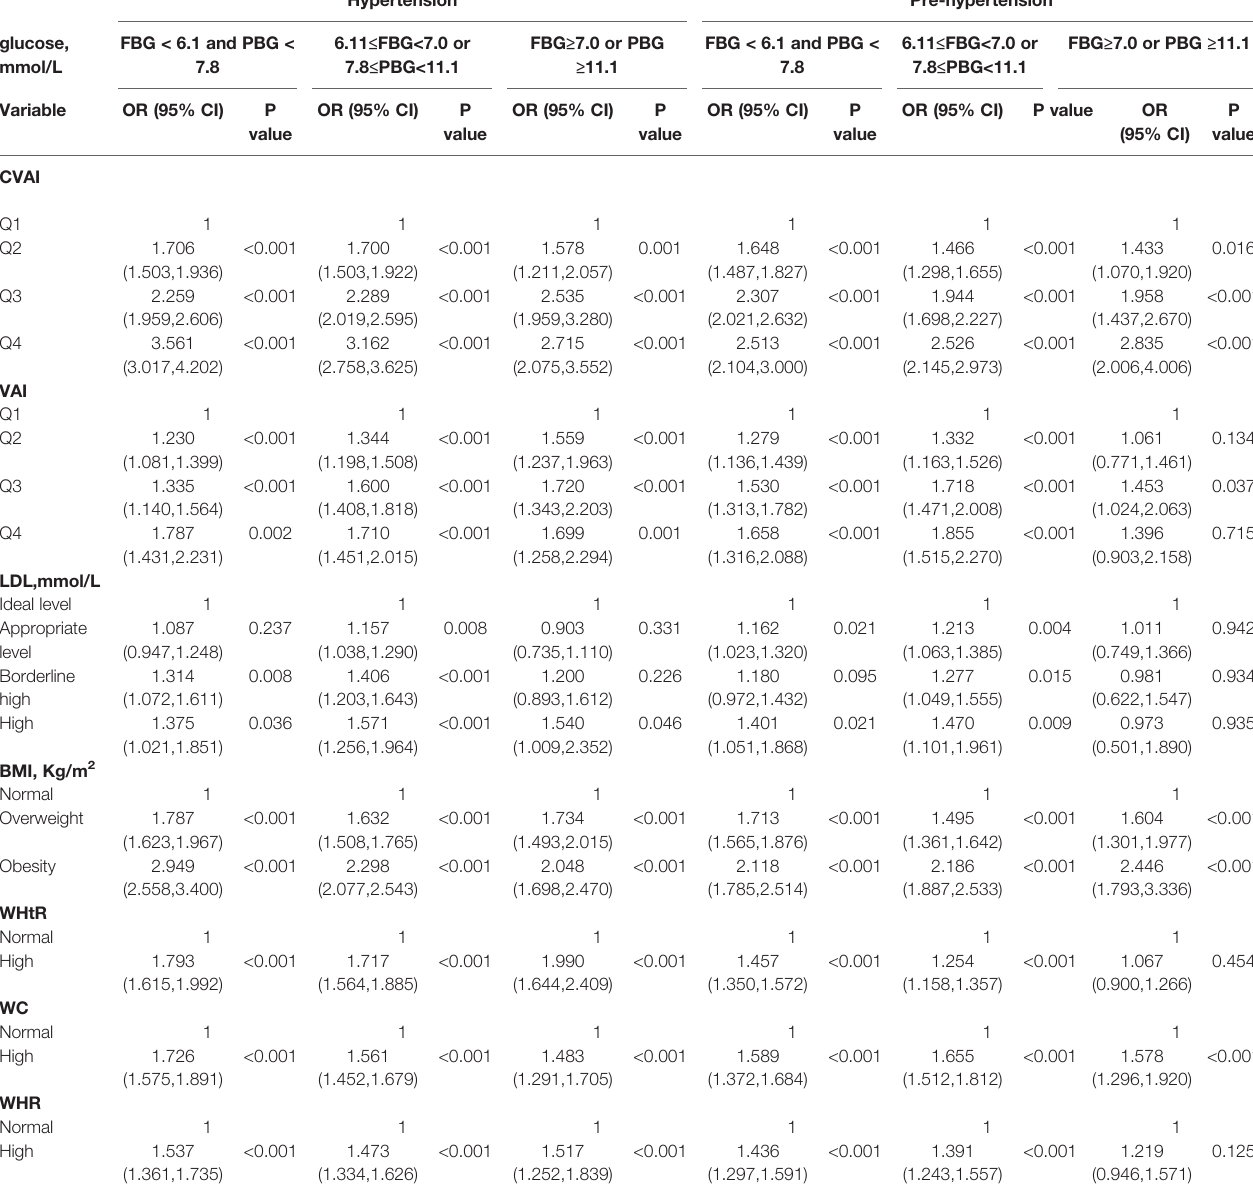
People with high WHR (WHR ≥ 0.90 for men or ≥ 0.85 for women) were signi fi cantly associated with hypertension in both genders and at any level of blood glucose, age and eGFR. People with high WHR were signi fi cantly associated with prehypertension in both genders, in all age subgroups, in normal blood glucose, when prediabetes, when eGFR ≥ 90ml/min per 1.73 m(2) and eGFR at 60-90 ml/min per 1.73 m(2).